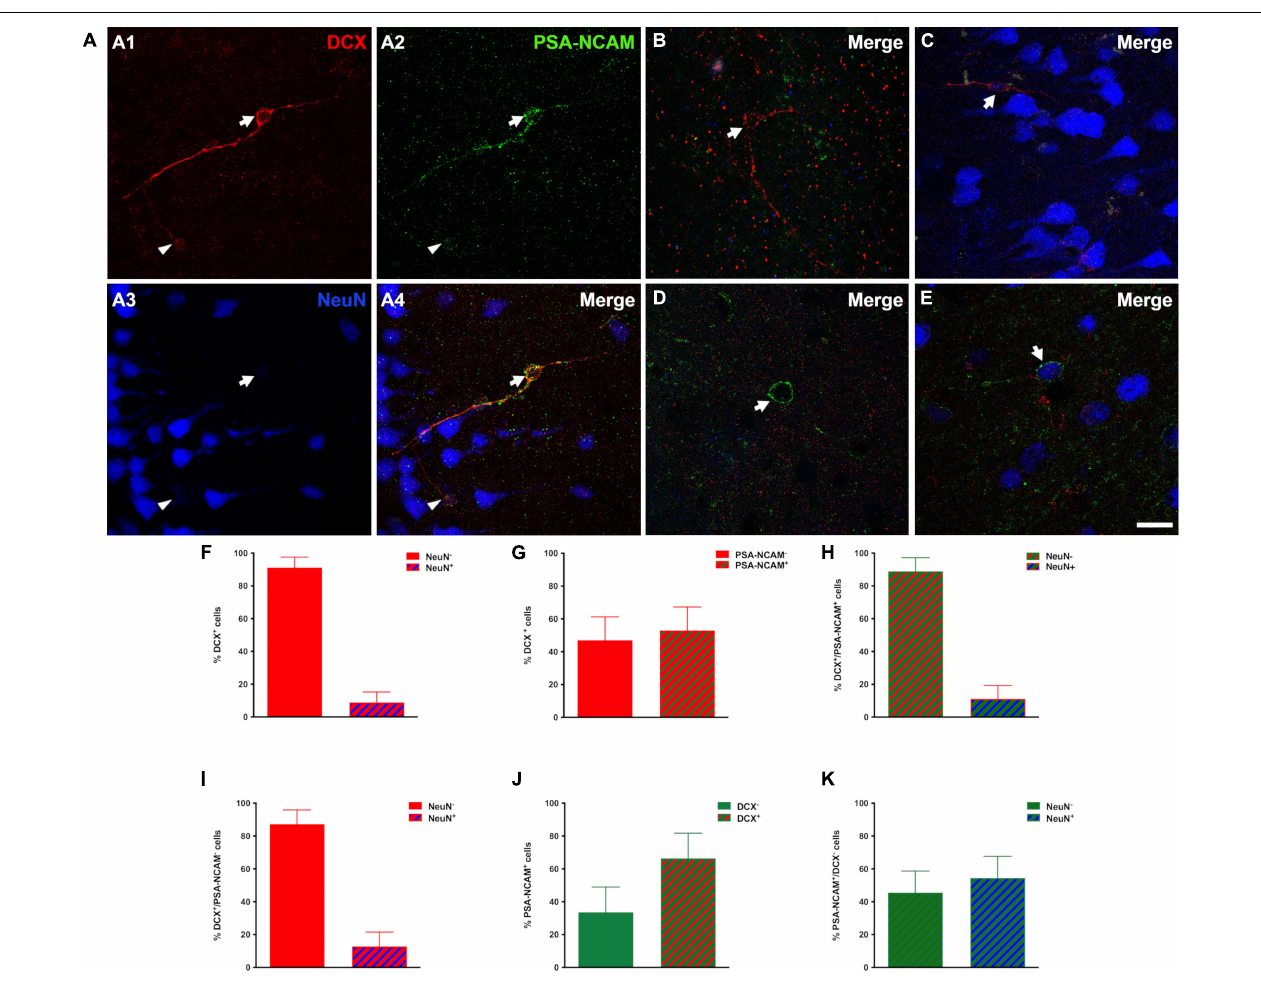
FIGURE 2 | Immature phenotype of DCX immunoreactive cells in the human cerebral cortex layer II. (A–E) Triple-immunofluorescence for DCX (red), PSA-NCAM (green) and NeuN (blue) in the layer II of the occipital lobe. (A1–4) Cells colocalizing DCX and PSA-NCAM and lacking NeuN immunoreactivity in their nuclei. Note the presence of a large (type II) DCX + /PSA-NCAM + cell (arrow) and a smaller one (type I, arrowhead). (B) DCX positive type II cell lacking PSA-NCAM and NeuN expression. (C) Type II cell expressing DCX and NeuN and lacking PSA-NCAM immunoreactivity. (D) PSA-NCAM positive cell lacking DCX and NeuN expression. (E) Cell immunoreactive for PSA-NCAM and NeuN and lacking DCX expression. (F,G) Graphs showing the percentage of DCX + cells displaying NeuN immunoreactive nuclei (F) or co-expressing PSA-NCAM (G) . (H) Graph showing the percentage of DCX + /PSA-NCAM + cells displaying a NeuN + nucleus. (I) Graph showing the percentage of PSA-NCAM + /DCX- cells displaying a NeuN immunoreactive nucleus (J) Graph showing the percentage of PSA-NCAM + co-expressing DCX. (K) Graph showing the percentage of PSA-NCAM + /DCX- cells displaying a NeuN immunoreactive nucleus. Error bars